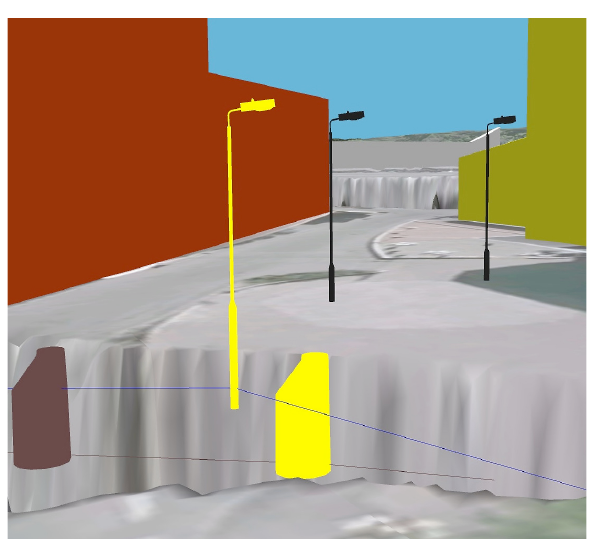
Figure 4. Two selected GMO's - light pole and manhole